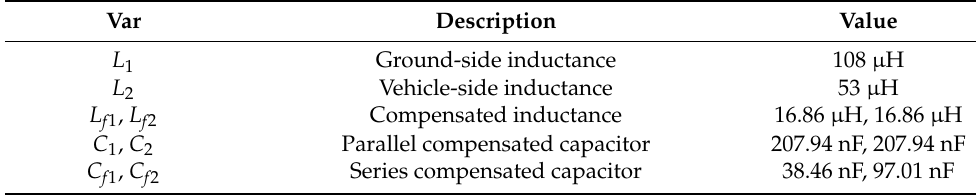
Table 5. Circuit Parameters of System.